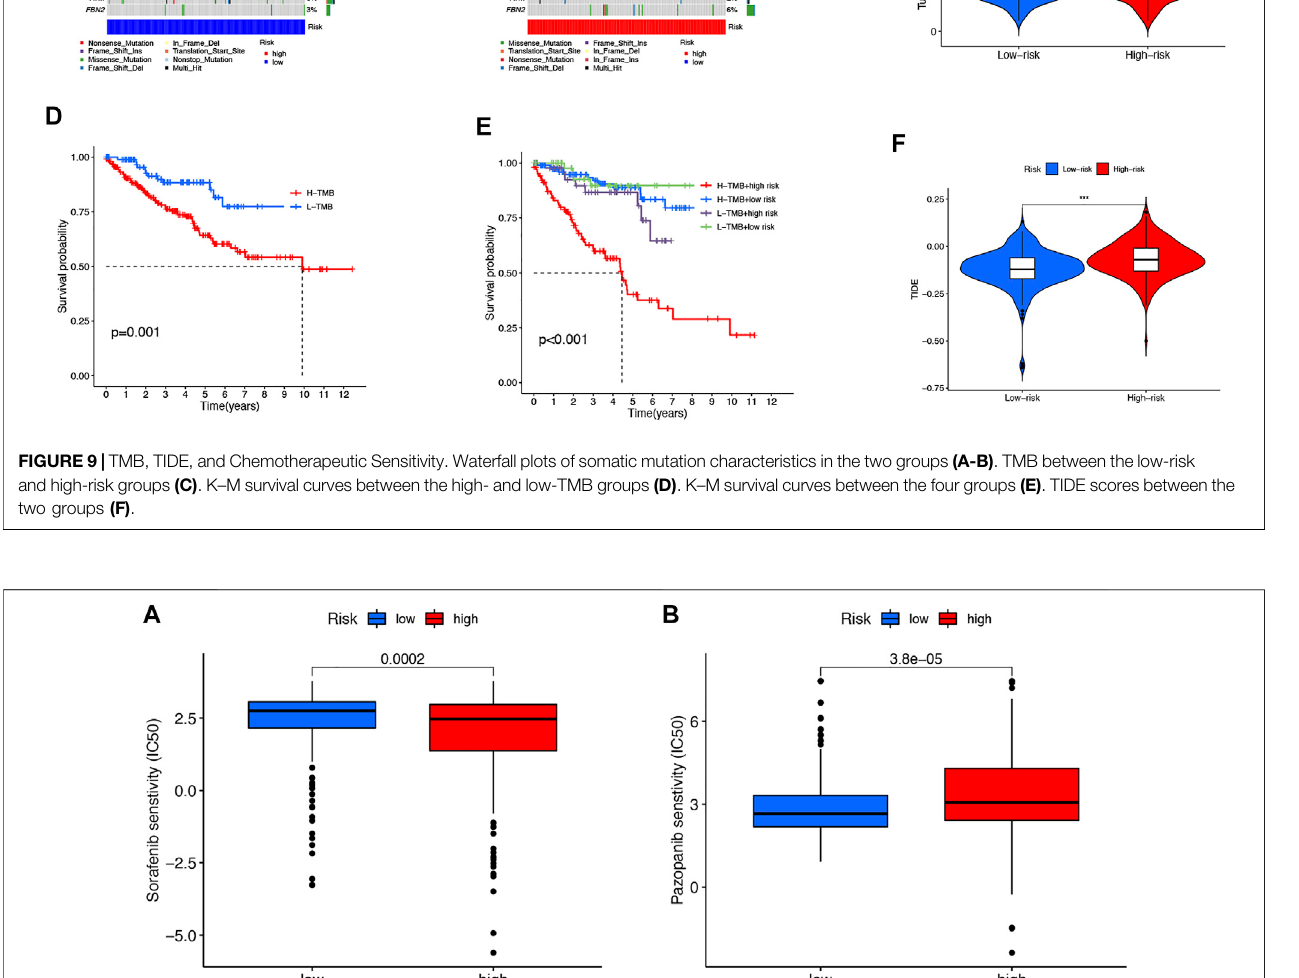
Frontiers in Genetics |